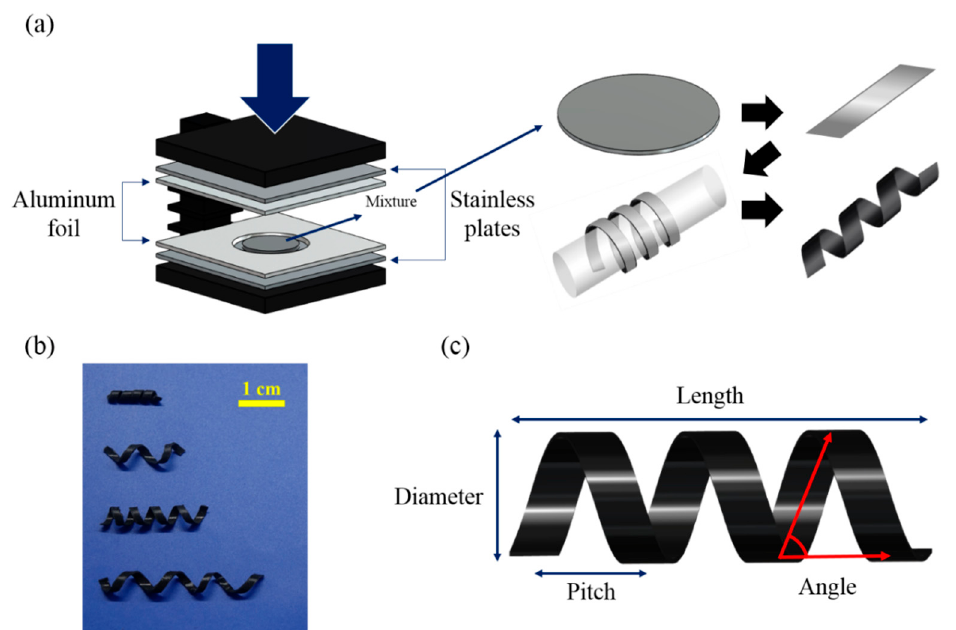
Figure 1. ( a ) Schematic fabrication process for magnetic helical soft robots comprising 3 vol% CIP (carbonyl iron particle) embedded in PDMS (polydimethylsiloxane) matrices ( b ) Digital images of four different samples (D2-L15, D5-L20, D5-L25, and D5-L35 from top to bottom) ( c ) Scheme for illustrating parameters of the helix geometry. Note: The names of the robot samples correspond to the diameter (D) and length (L) (in mm) of their helical coils. Table 1. Weight and dimension information of helical soft robots.